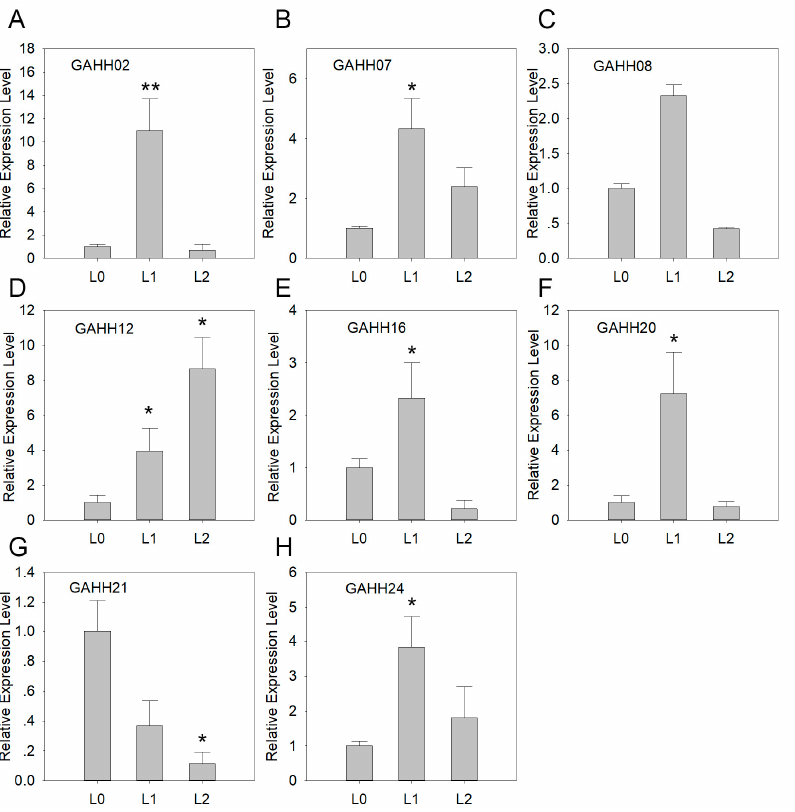
Figure 3. Expression patterns of GAHH02 ( A ), GAHH07 ( B ), GAHH08 ( C ), GAHH12 ( D ), GAHH16 ( E ), GAHH20 ( F ), GAHH21 ( G ), and GAHH24 ( H ) at different leaf developmental stages in A. H11648 by qRT-PCR. Y -axis represents relative expression level. L0, L1 and L2 of x -axis represent shoot, unexpanded leaf and expanded leaf, respectively. The error bar represents the standard error. * and ** represent that expression level was increased or decreased by more than 3-fold and 10-fold, respectively (compared with shoot).